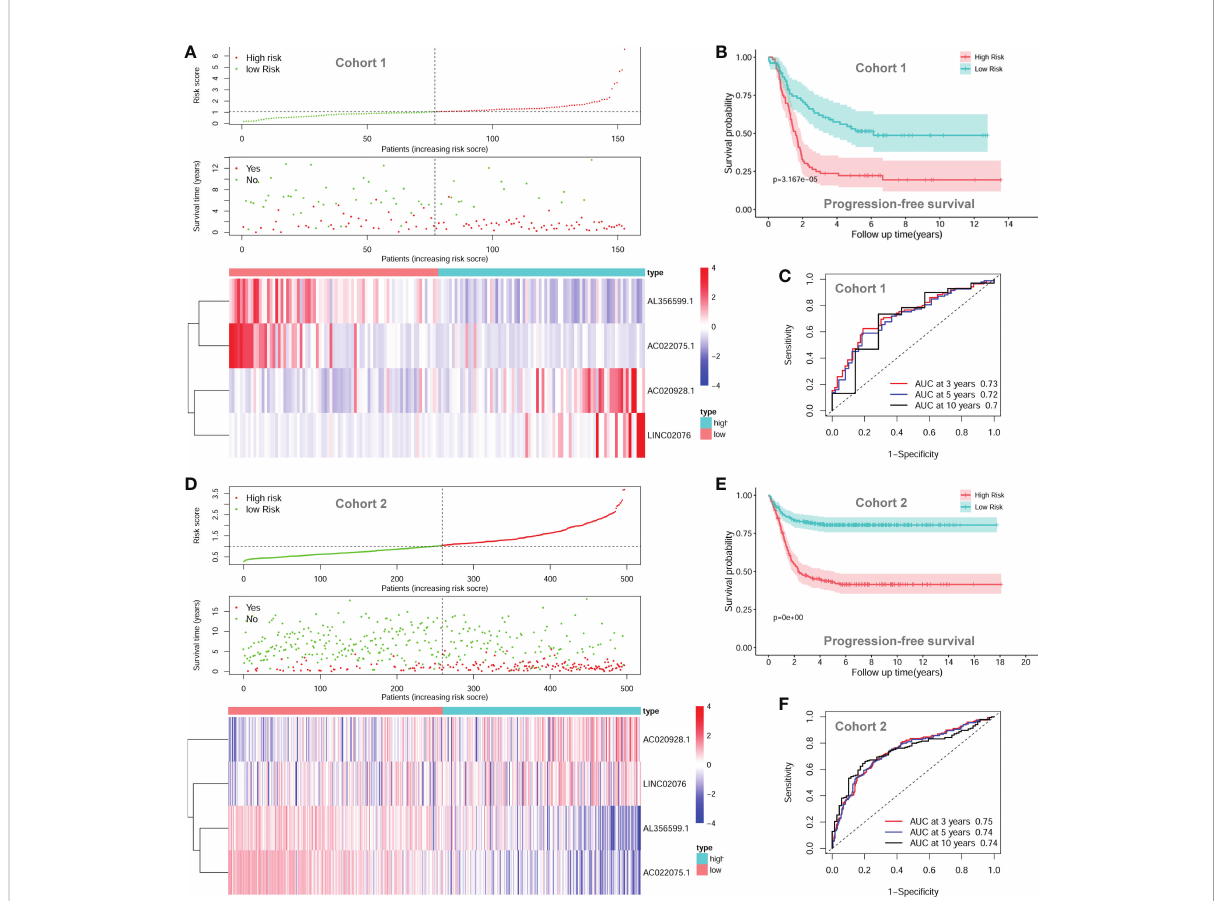
FIGURE 5 The autophagy-related four-lncRNA signature risk score. (A) The distribution of risk scores, survival status of each patient, and heatmap of lncRNAs expression pattern in cohort 1. (B) Kaplan-Meier survival curve for PFS of patients in the low-risk group and high-risk group for cohort 1. (C) Time-dependent ROC curves of the lncRNA signature in cohort 1. (D) The distribution of risk scores, survival status of each patient, and heatmap of lncRNAs expression pattern in cohort 2. (E) Kaplan-Meier survival curve for PFS of patients in the low-risk group and high-risk group for cohort 2. (F) Time-dependent ROC curves of the lncRNA signature in cohort 2. lncRNA, long noncoding RNA; PFS, progression-free survival; ROC, Receiver Operating Characteristic; AUC, Area Under